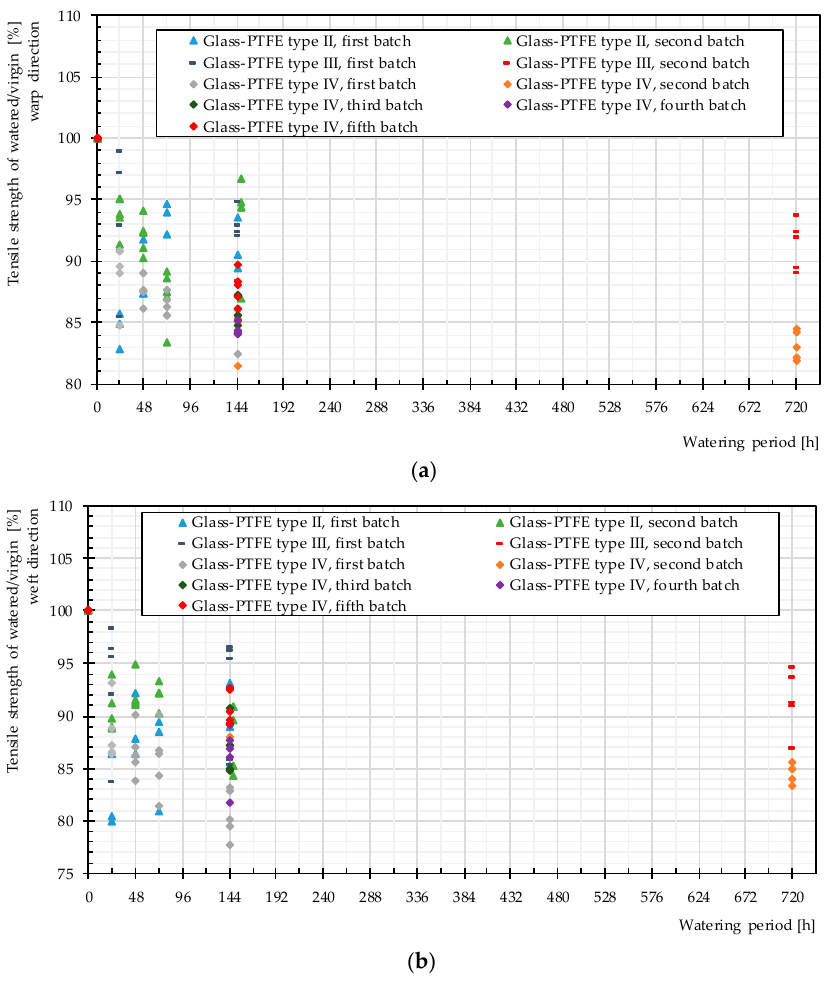
Figure 10. Stiffness changes of glass-PTFE samples according to Table 3 for different watering time periods. Continuous lines: warp direction, dashed lines: weft direction.